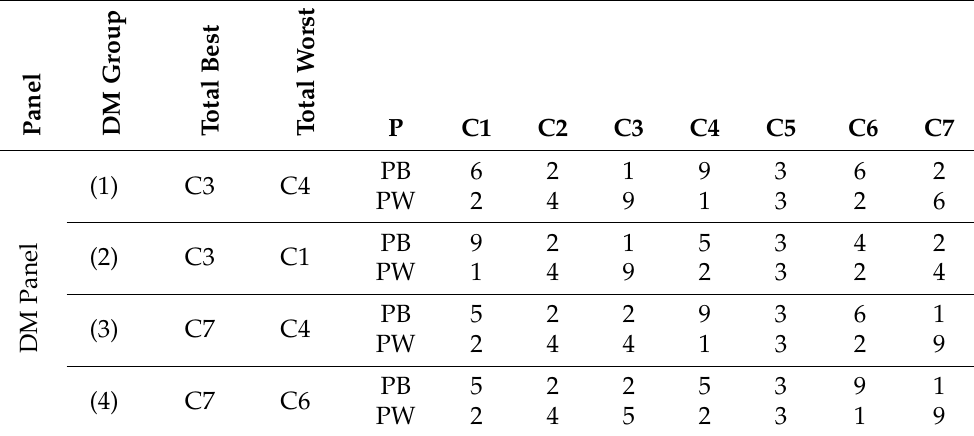
Table 3. Total preference of pairwise comparisons for the best and worst